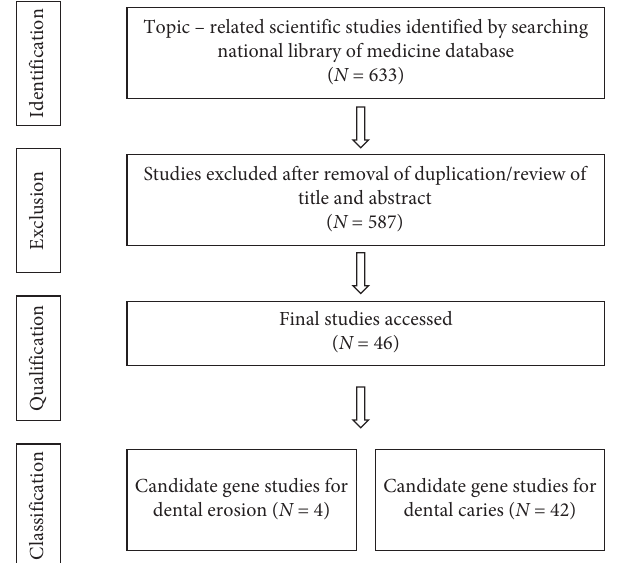
Figure 1: Studies selection